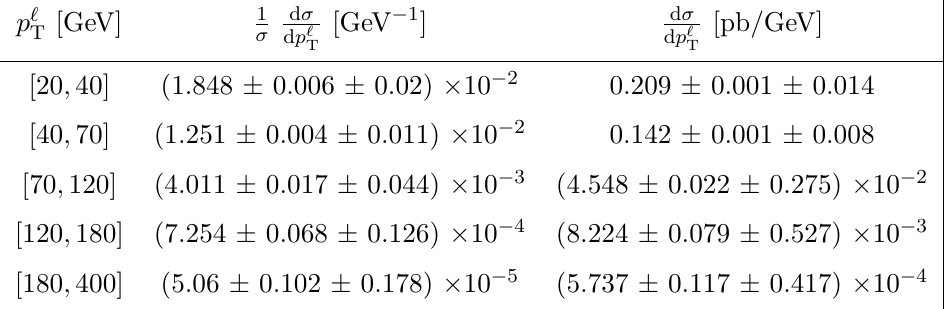
Table 29 . The measured di(cid:11)erential cross section and bin boundaries for each bin of the normalized and absolute measurements of the tt di(cid:11)erential cross section at particle level in the (cid:12)ducial phase space as a function of p ‘ are tabulated. T